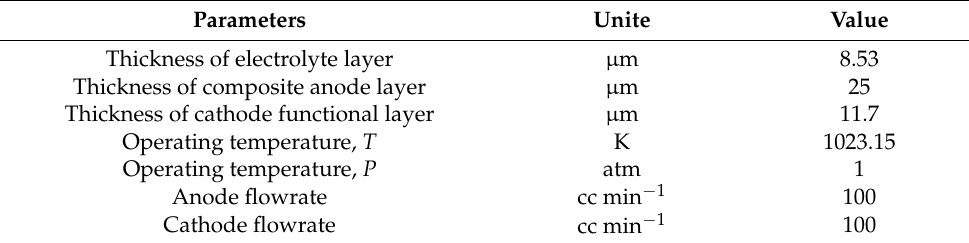
Figure 3. Experimental and model I – V curves at different inlet H 2 O mole fraction. Table 7. Basic operating parameters for model validation by different inlet H 2 O mole fractions